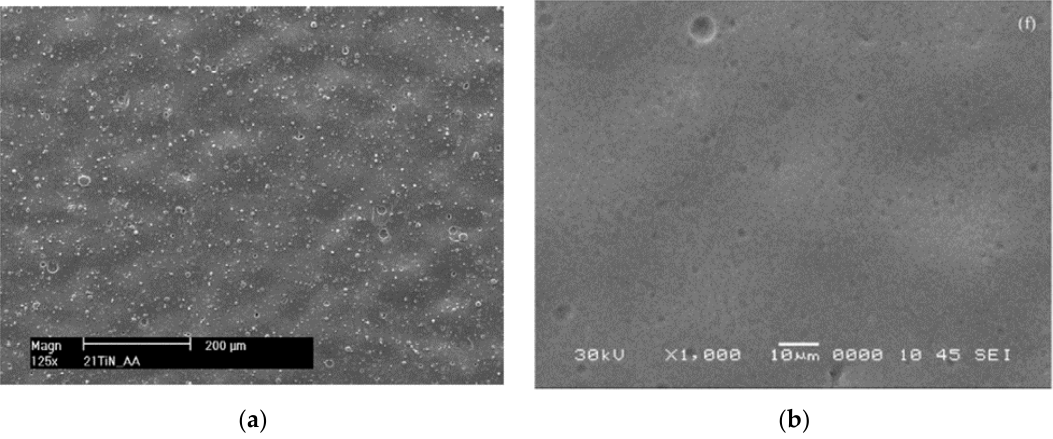
Figure 6. Undulation of ( a ) 3.6 μ m thick TiN coating deposited on X6CrNiTi18-10 steel by means of a cathodic arc evaporation physical vapor deposition (PVD) method, reprinted from Engineering Failure Analysis , Reference [94], with permission from Elsevier and ( b ) 3.78 μ m thick NiTi coating produced on mild steel using the filtered arc deposition PVD method, reprinted from Wear , Reference [80], with permission from Elsevier.